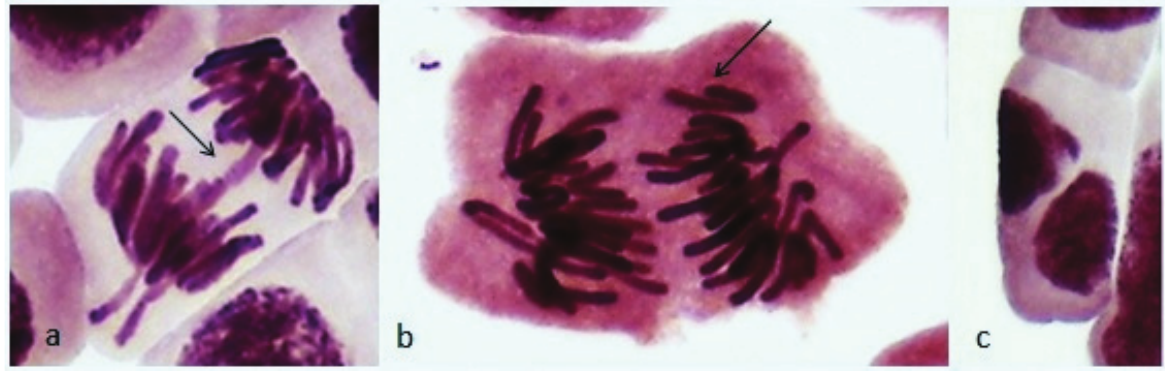
Figure 1 - Chromosomal abnormalities observed in Allium cepa cells after application of tricyclazole. ( a ): anaphasic bridges ( b ): laggard chromosomal (c) : binucleate cell. Santa Maria,